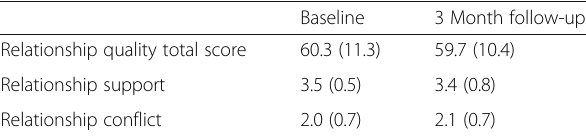
Table 4 Relationship quality measures at baseline and 3 month follow-up for married/partnered participants ( N =